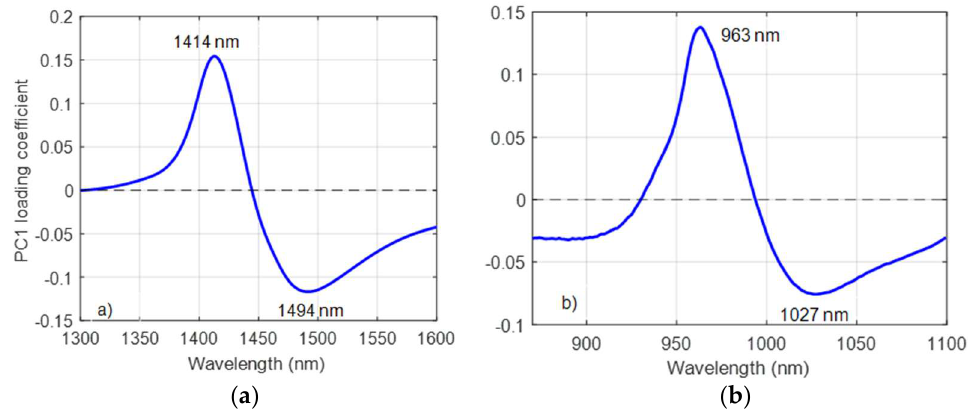
Figure 6. PC1 loading of water in ( a ) the first overtone and ( b ) the second overtone region of the OH stretch of water. Labels indicate peak and trough wavelengths.